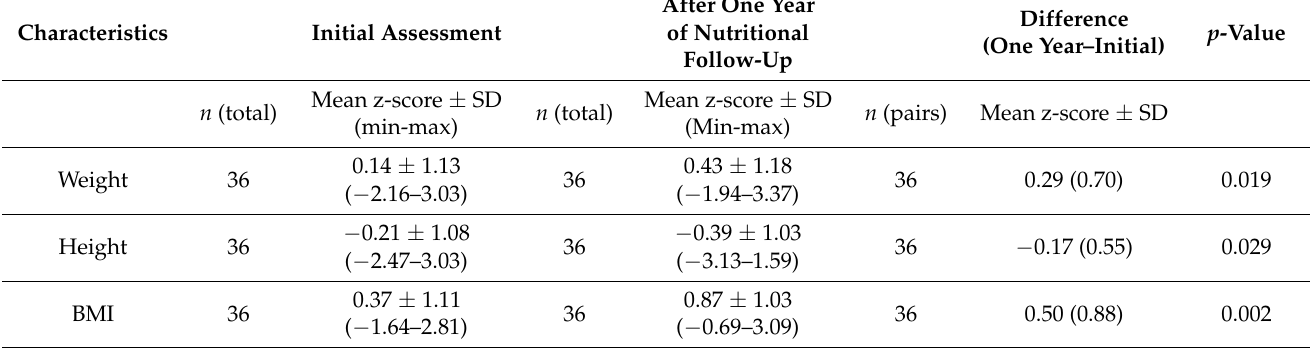
Table 3. Clinical and anthropometric characteristics of the participants at the initial assessment and after one year of nutritional